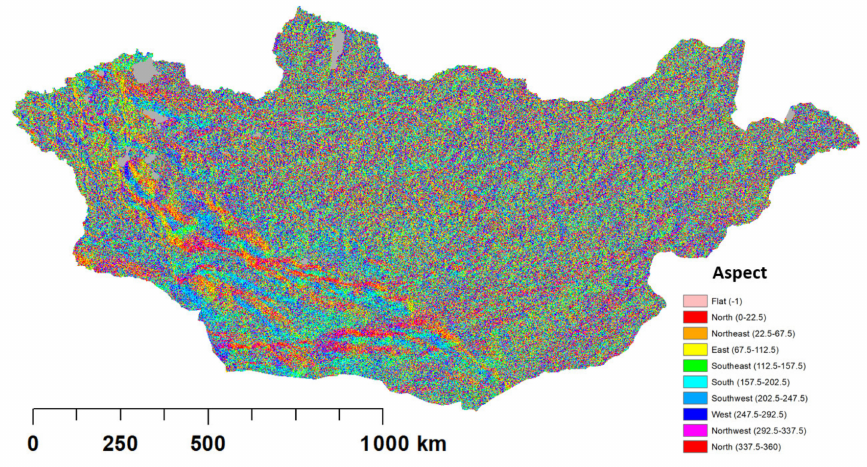
Figure 7. Aspect data for Mongolia, derived from a digital elevation model. Proximity to main roads and major power transmission lines affects the cost of infrastruc- ture construction and the associated environmental damage [12,27]. The major Mongolian main roads and power transmission lines are illustrated in Figures 8 and 9, respectively.